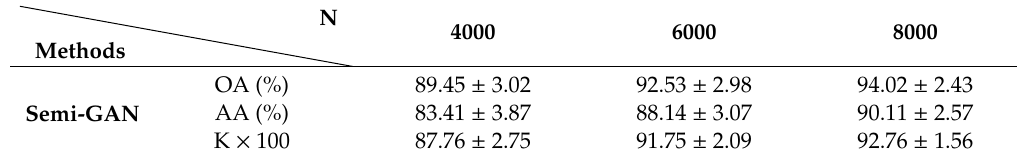
Table 9. Test accuracy with di ff erent training samples numbers on Indian Pines dataset.